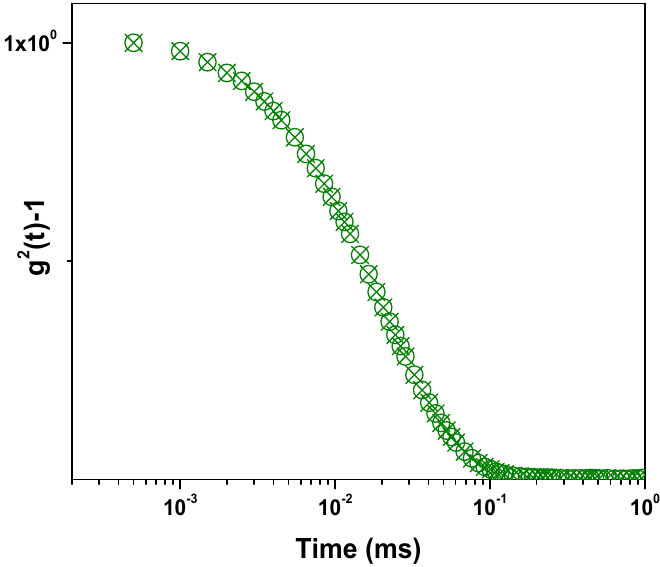
Figure 1. Dynamic Light Scattering autocorrelation function of microemulsions.